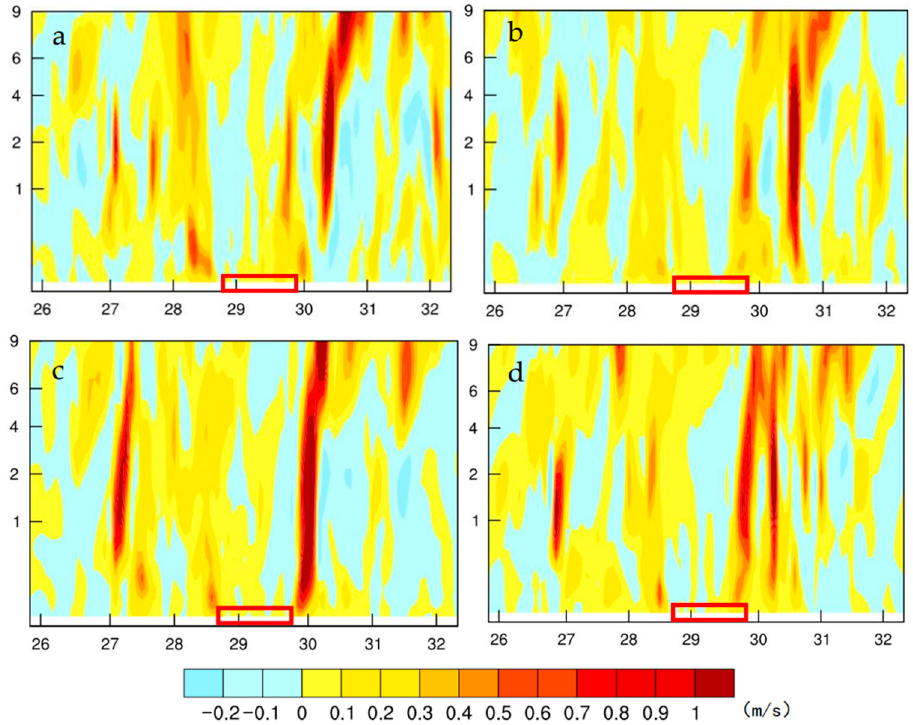
Figure 6. The same as Figure 5, but for vertical velocity (unit: m ∙ s − 1 ; the red box is the center of the